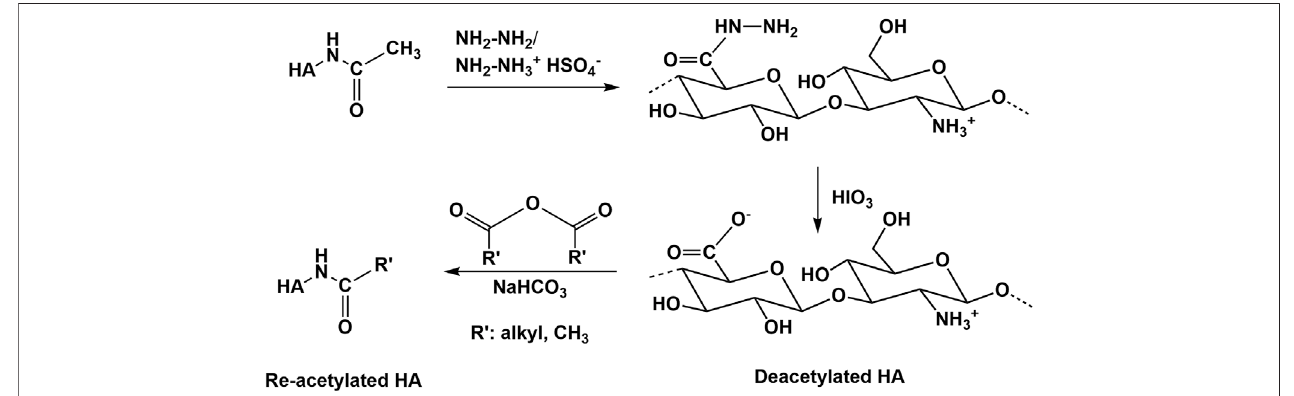
FIGURE 11 | Deacetylation of HA with